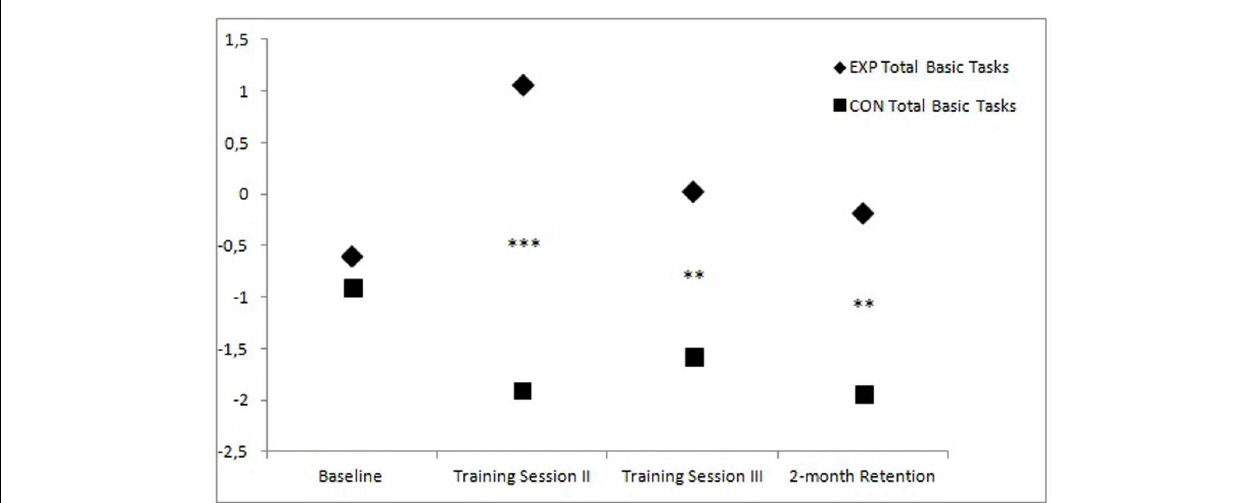
FIGURE 1 | Standardized total scores of the first four basic laparoscopic tasks at the start of the first training sessions (baseline), at the end of the second and third training session, and at retention for both training groups (Between-subject differences: ∗ p < 0.05; ∗∗ p < 0.01; ∗∗∗ p <